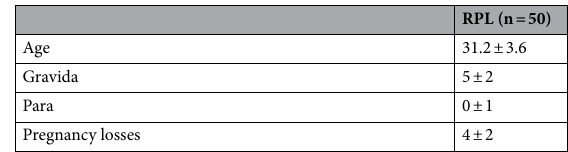
Table 1. Baseline characteristics of study population. Baseline characteristics of study population, data are presented as average ± standard deviation.